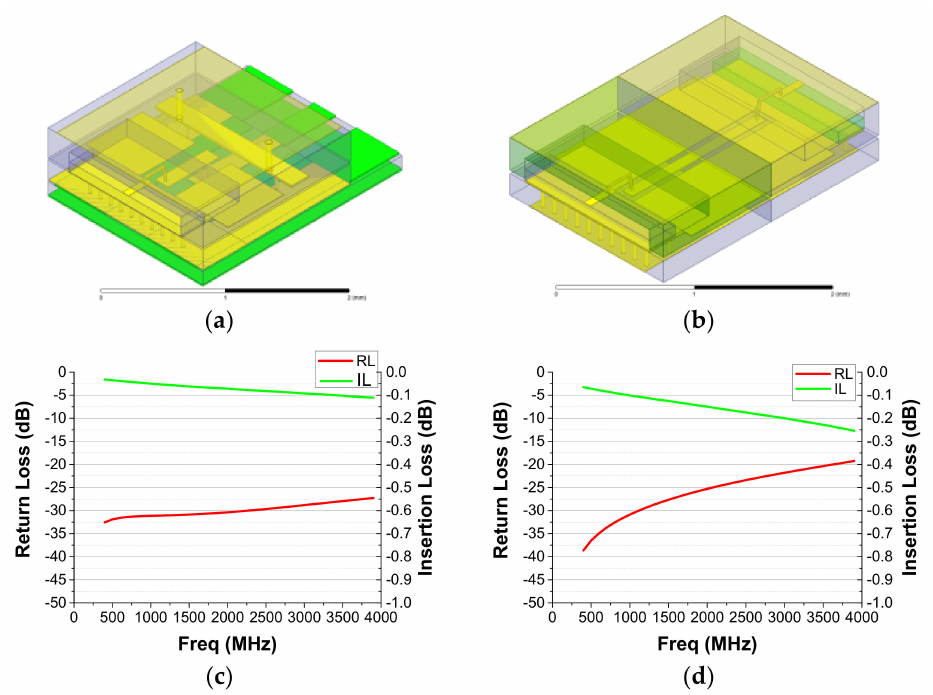
Figure 14. Key RF structures of the module with 3D EM simulation results. ( a )simplified model of A structure, ( b ) simplified model of B structure, ( c ) simulation of A structure, ( d ) simulation of B structure.